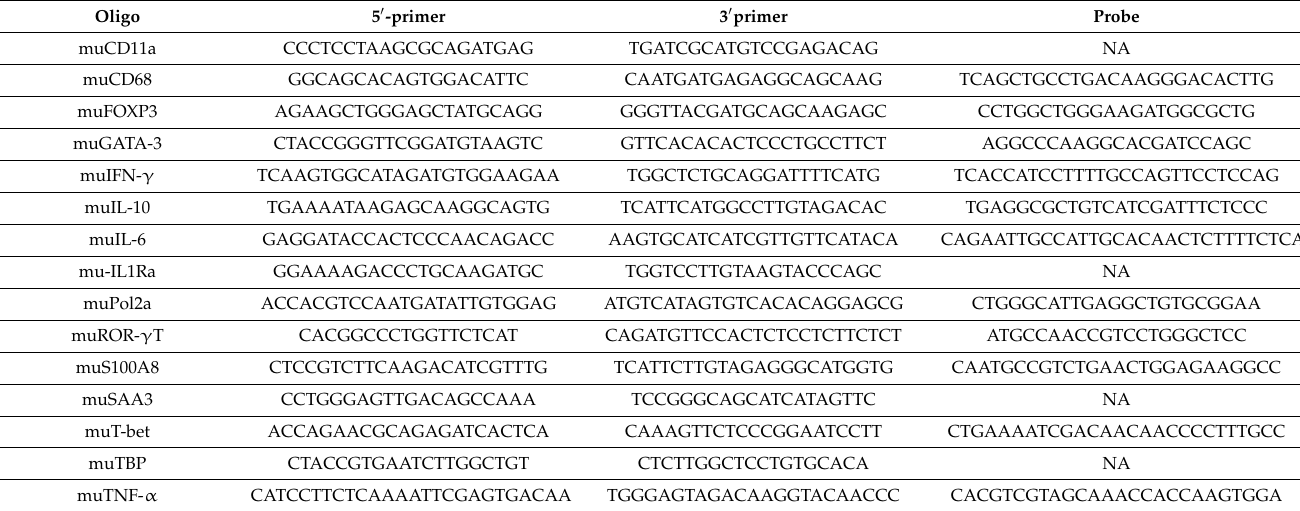
Table 1. Oligos and probes used for